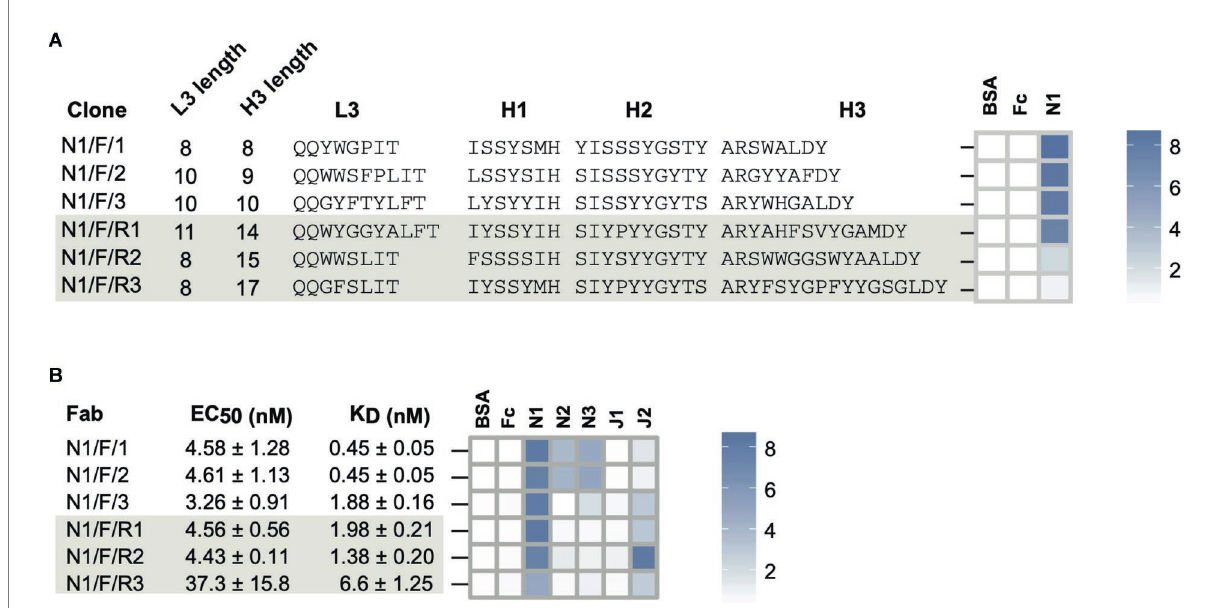
FIGURE 3 Notch-1 Fabs from Library-F. (A) Sequence characteristics and phage-displayed Fab binding characteristics of 3 top Fabs (N1/F/1, N1/F/2, and N1/F/3) isolated by Sanger sequencing and 3 rare Fabs (N1/F/R1, N1/F/R2, and N1/F/R3) reconstructed from L3-H1-H2-H3 NGS information. (B) Affinity and specificity of purified Notch-1 Fabs. Fab specificity was determined at 1 μ M Fab concentration. Phage-ELISA and specificity-ELISA ABS 450 values are shown as heatmaps. Fab nomenclature is listed as Target/Library/Clone number. Notch-1, Notch-2, Notch-3, Jagged-1, and Jagged-2 are indicated as N1, N2, N3, J1, and J2, respectively. S and F indicate library S, Library F, respectively. The clone number is listed in the third position and if they are a “rare” clone they have an “R” in front of the